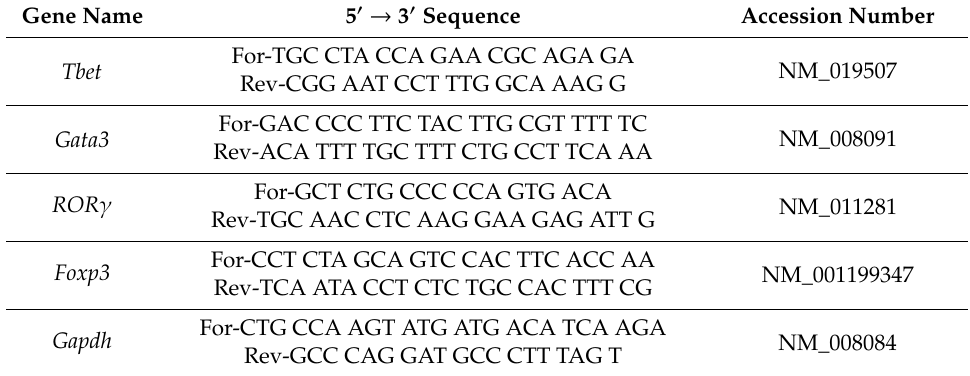
Table 1. The characteristics of the primer used for qPCR. GAPDH was used as housekeeping gene sequences are expressed from the 5 (cid:48) to the 3 (cid:48) region and were designed using primer express